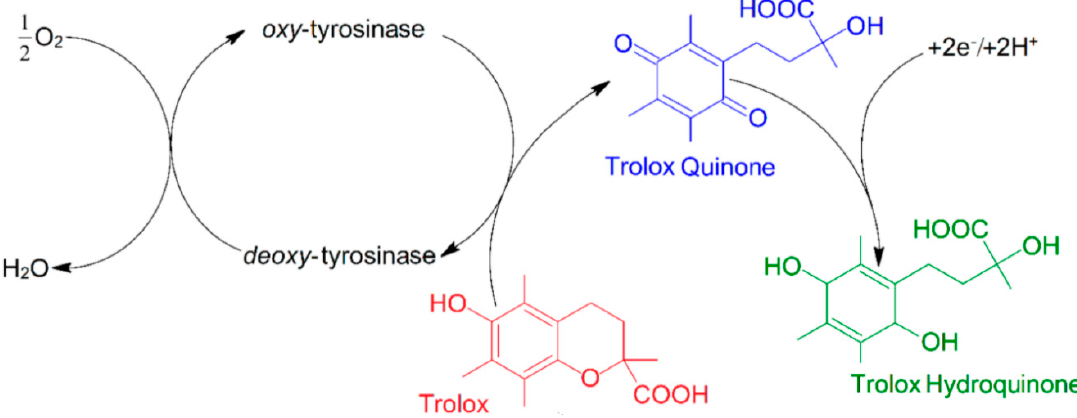
Figure 5. Principle of amperometric biosensor based on tyrosinase for TEAC evaluation